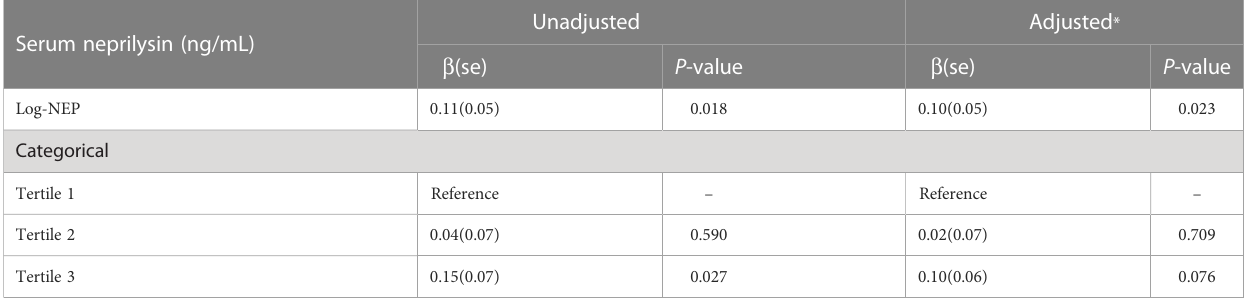
TABLE 2 The longitudinal association between baseline serum neprilysin and dynamic fasting plasma glucose during follow-up.